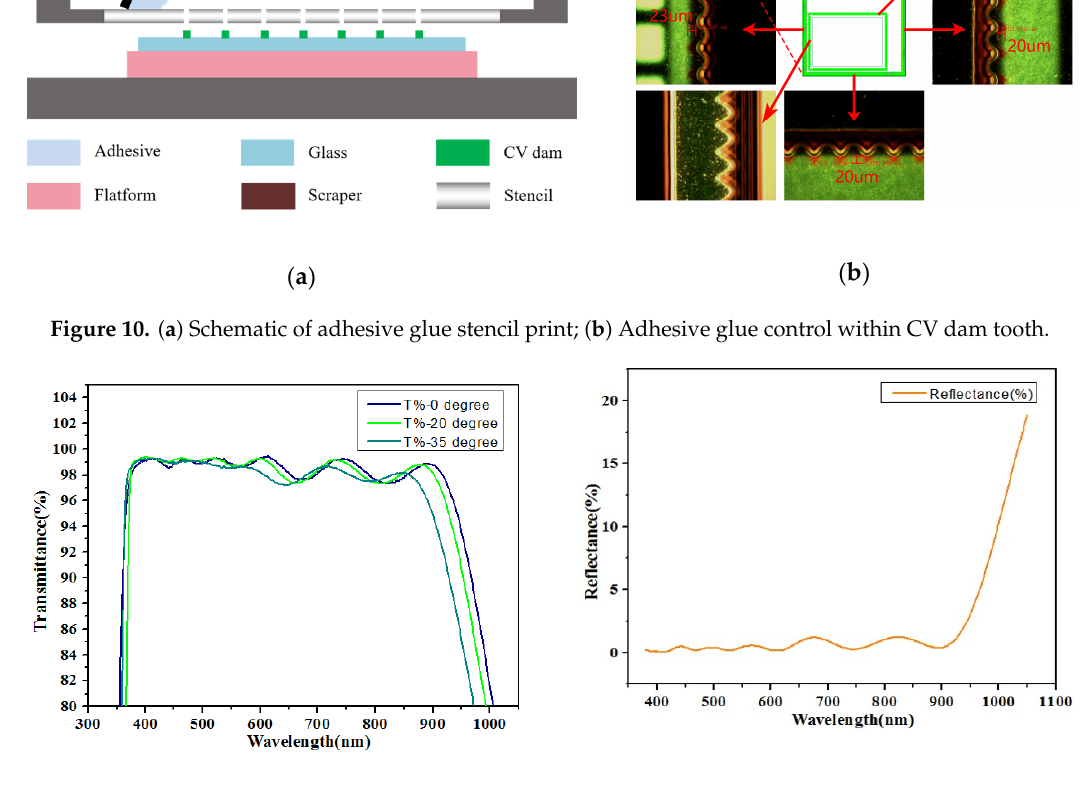
Figure 10. ( a ) Schematic of adhesive glue stencil print; ( b ) Adhesive glue control within CV dam tooth.